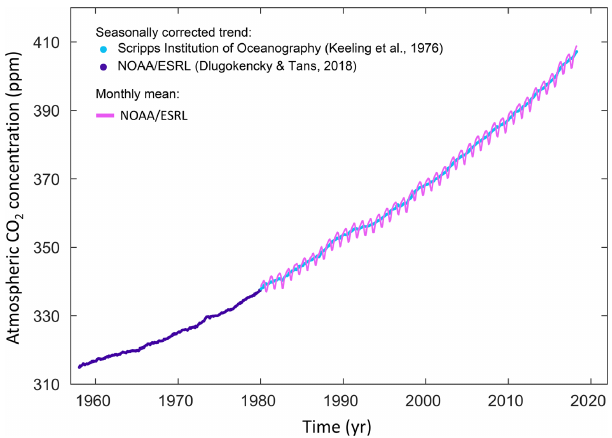
Figure 1. Surface average atmospheric CO 2 concentration (ppm). The 1980–2018 monthly data are from NOAA/ESRL (Dlugokencky and Tans, 2018) and are based on an average of direct atmospheric CO 2 measurements from multiple stations in the marine boundary layer (Masarie and Tans, 1995). The 1958–1979 monthly data are from the Scripps Institution of Oceanography, based on an average of direct atmospheric CO 2 measurements from the Mauna Loa and South Pole stations (Keeling et al., 1976). To take into account the difference of mean CO 2 and seasonality between the NOAA/ESRL and the Scripps station networks used here, the Scripps surface av- erage (from two stations) was deseasonalised and harmonised to match the NOAA/ESRL surface average (from multiple stations) by adding the mean difference of 0.542ppm, calculated here from overlapping data during